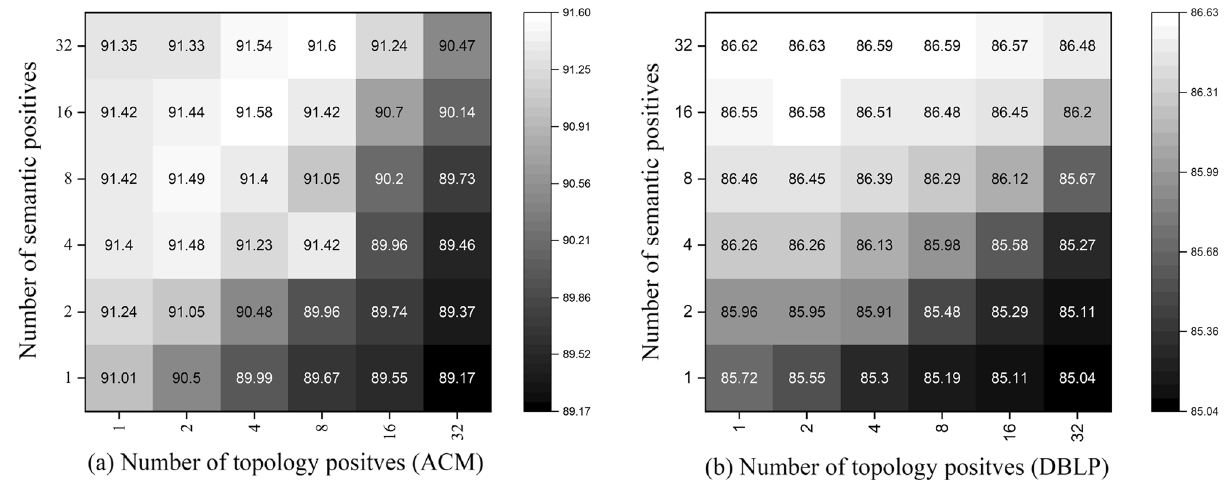
Figure 3. Hyperparameter sensitivity of positive sampling thresholds on node classification (ACM and DBLP).